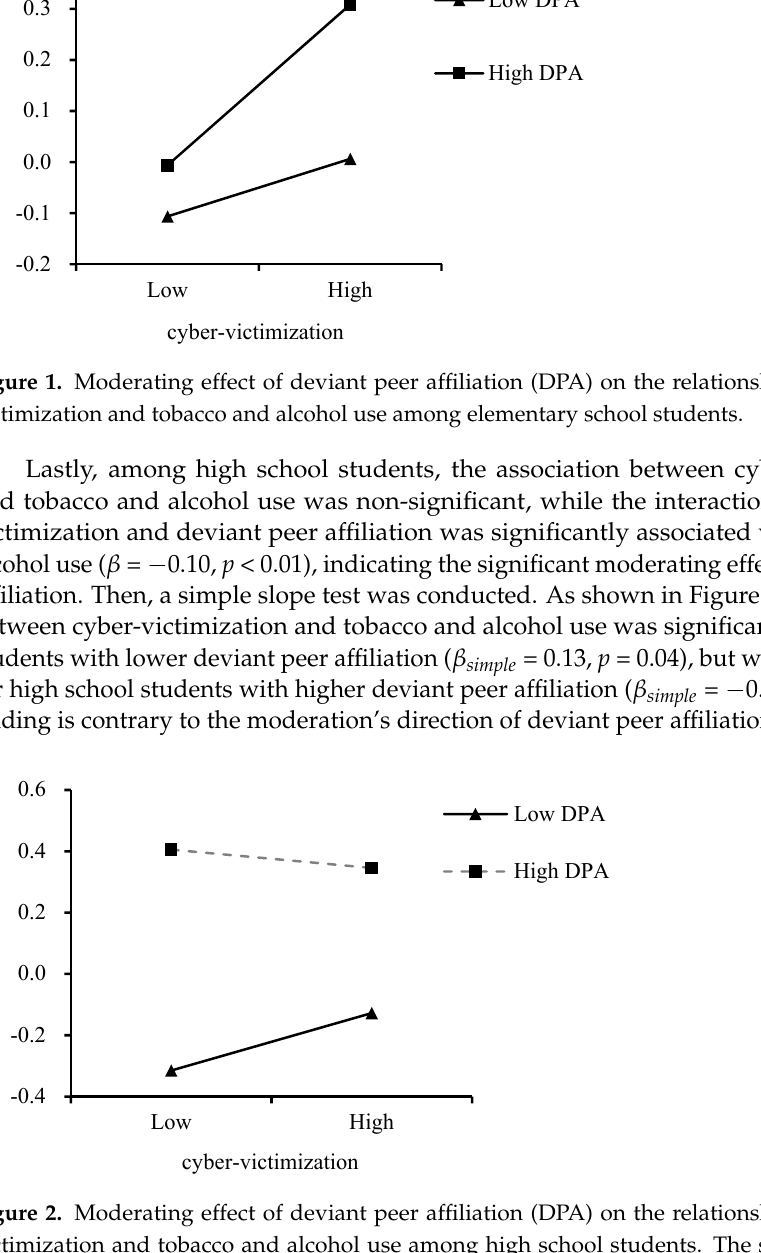
Figure 2. Moderating effect of deviant peer affiliation (DPA) on the relationship between cyber- victimization and tobacco and alcohol use among high school students. The solid black slope is significant ( p < 0.05), the dashed grey slope is not.